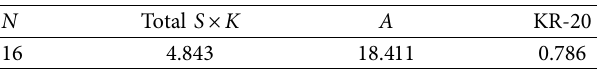
Table 5: The reliability coefficient of the test of basic science processes with the Couder-Richardson equation 20.